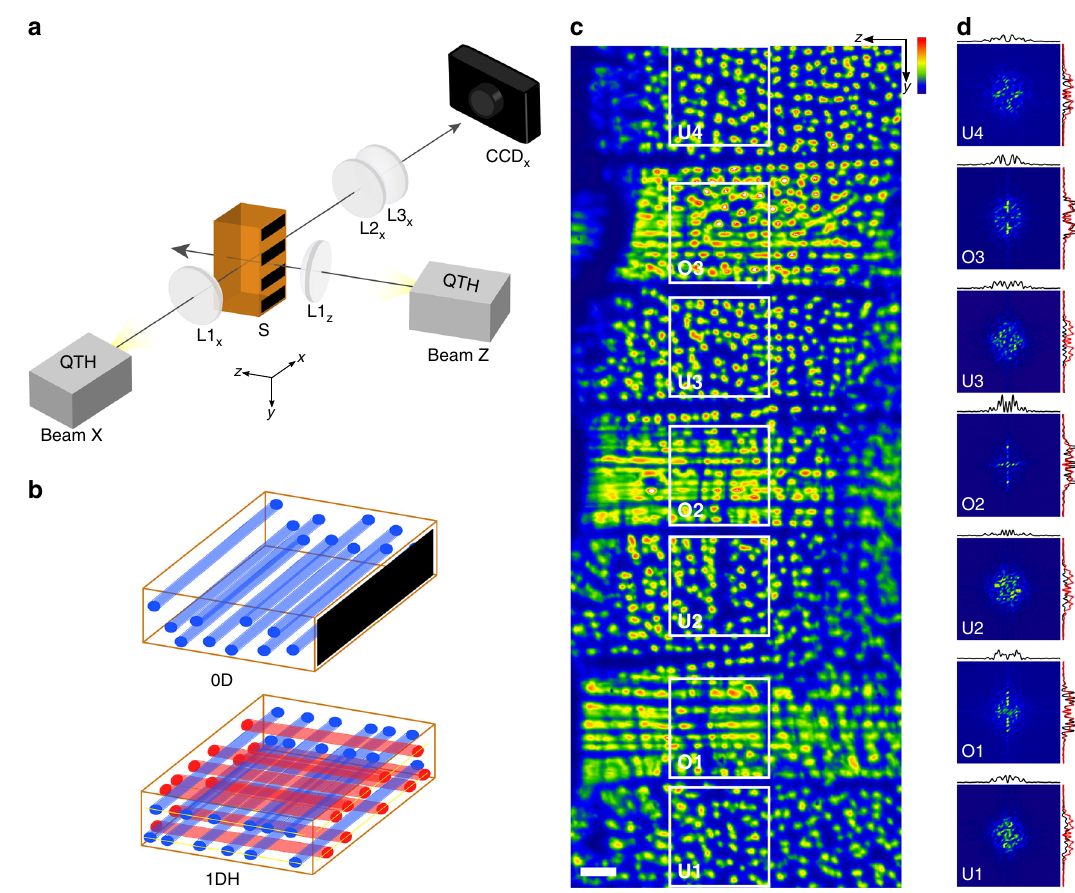
Fig. 2 Recognition and transfer of a binary string of light. A binary string comprising a seven dark and bright stripes (bits) is launched through Beam Z into the polymer cuboid (S). Beam Z is emitted by a quartz – tungsten halogen (QTH) lamp and collimated through planoconvex lens L1 z . The spatial intensity pro fi le of Beam X (emitted by a QTH lamp and collimated through planoconvex lens L1 x ) at the output ( yz ) plane is imaged through a pair of planoconvex lenses (L2 x , L3 x ) onto a charge coupled device (CCD) camera. The output string consists of seven stripes of b alternating 0D and 1DH con fi gurations, which c corresponds to the input binary string (scale bar = 200 μ m; blue (minimum) to red (maximum) intensity scale provided). d Fast Fourier Transform (FFT) spectra of areas of the output contained in white squares. 1D vertical and horizontal pro fi les acquired through the origin are provided in black; for reference, averaged 1D vertical pro fi les of the entire spectrum are provided in